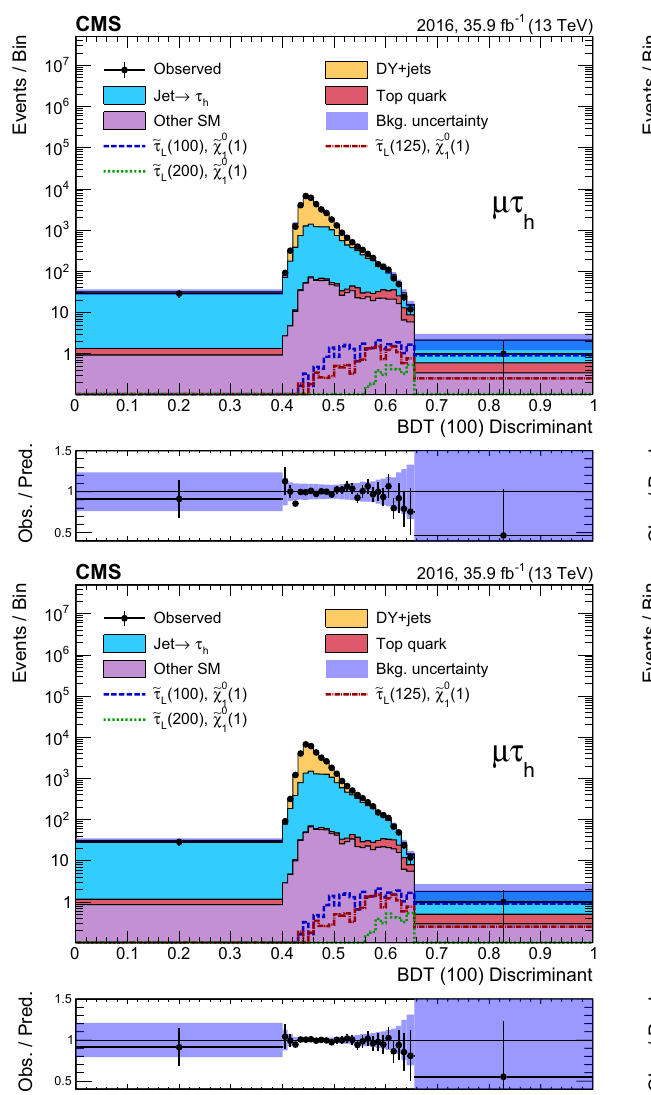
Fig. 6 Discriminant distributions for the BDT trained for a (cid:2) τ mass of 100GeV and a (cid:2) χ 0 mass of 1GeV (BDT (100)) in the μτ 1 the 2016 (left) and 2017 (right) data, before (upper) and after (lower)